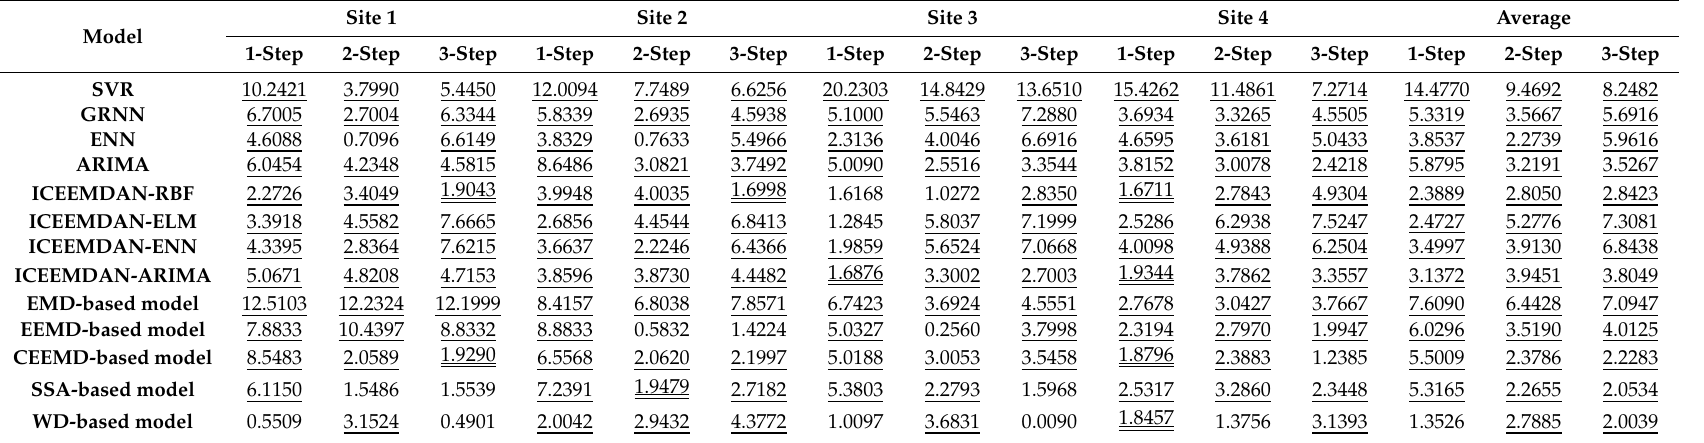
Table 8. Statistics value of DM test for experimented